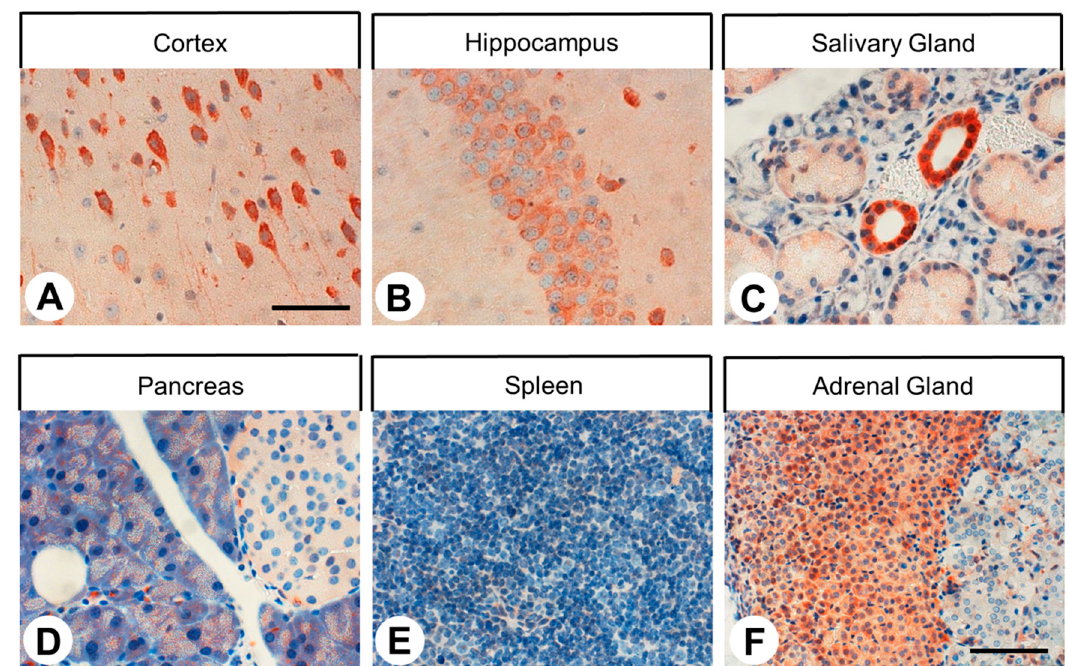
Figure 3. Evidence of SST4 expression in SST4-eGFP knockin mice. SST4 was detected immunohistochemically in tissue sections from SST4-eGFP knockin mice using a commercial rabbit anti-eGFP antibody (ab290, Abcam, Cambridge, UK; 1:1000). Scale bar: ( A – E ) = 60 µm; ( F ) = 100 µm.